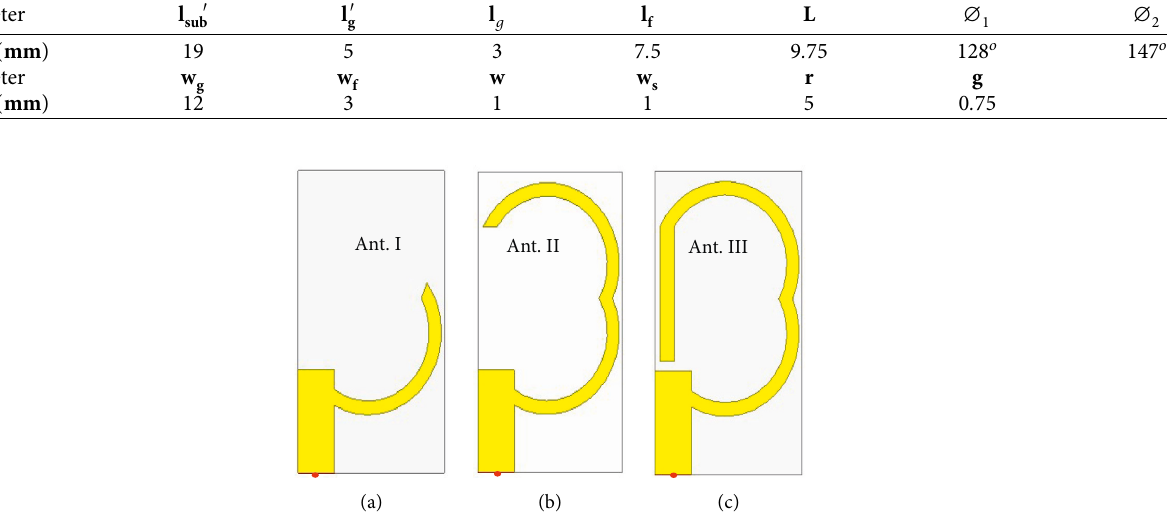
Figure 2: The Design Procedures(red dot represents the feeding point using lumped port).